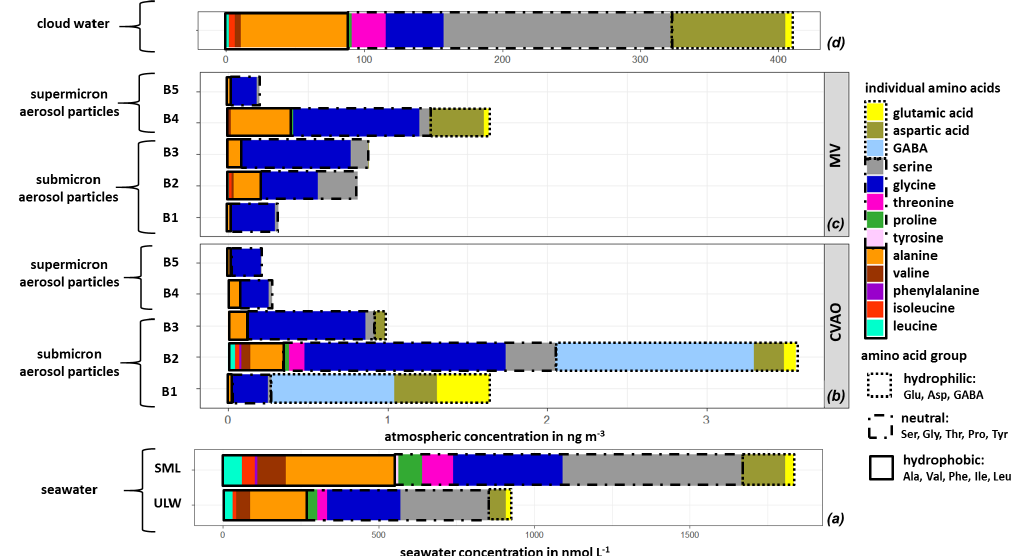
Figure 4. Case study: individual FAA concentrations in (a) seawater samples (ULW, SML; in nmolL − 1 ), in (b) size-segregated aerosol particle samples at the CVAO and (c) at the MV station (size range: 0–4ngm − 3 ) and in (d) cloud water samples (size range: 0–400ngm − 3